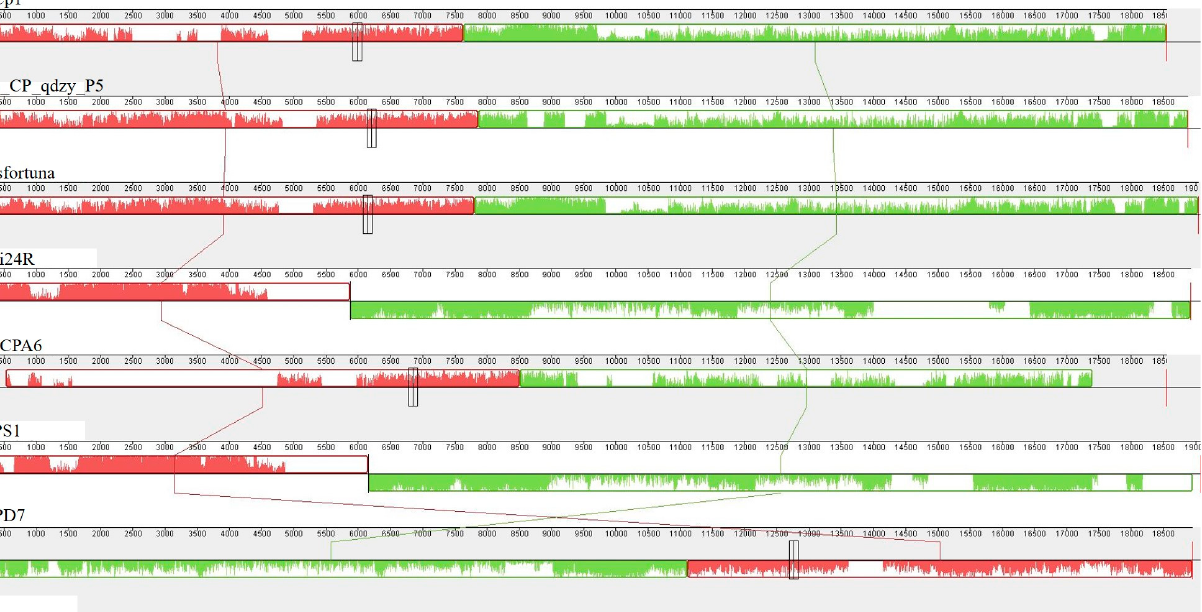
Figure 7. Comparative genomic analysis of phage DCp1 with phages vB_CP_qdzy_P5, susfortuna, phi24R, LPCPA6, CPS1, and CPD7 using Mauve. The nucleotide sequence similarity is indicated by the height of the colored bars, while the regions that are dissimilar are shown in white.